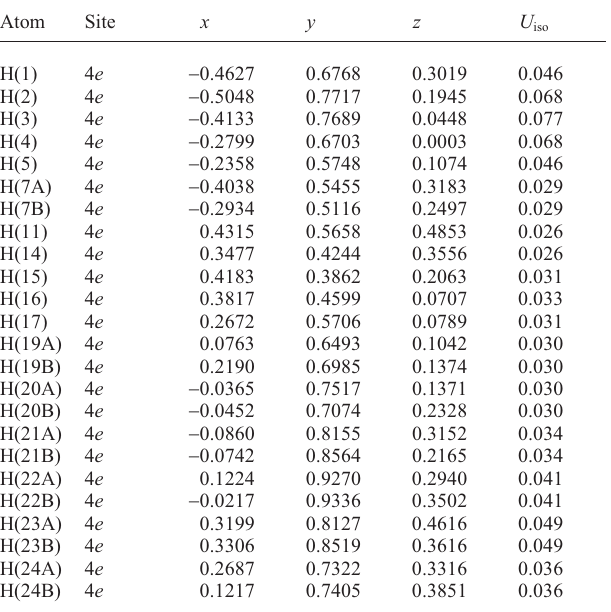
Table 2. Atomic coordinates and displacement parameters (in Å 2 )